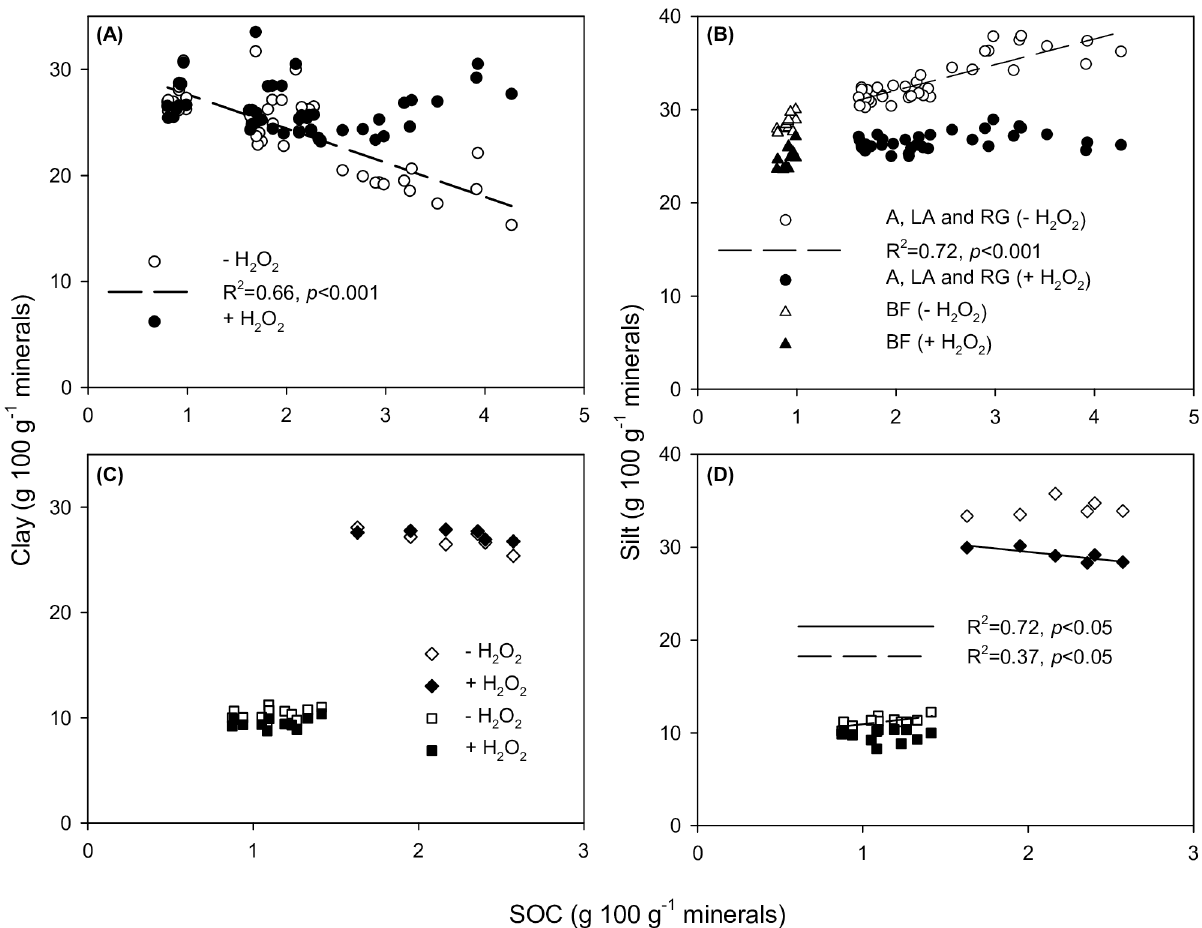
Fig 1. Clay ( < 2 μ m) and silt (2–20 μ m) content as a function of SOC content for soil samples pretreatedwith hydrogen peroxide and without pretreatment. (A) Clay content plotted against SOC content for soil samples pretreatedwith hydrogenperoxide(black symbols) and without pretreatment (white symbols) at Highfield.The linear regression line, R 2 and p -valuefor non-pretreated soil samples are indicated( n = 48). (B) Silt content plotted againstSOC content for soil samplespretreatedwith hydrogen peroxideand without pretreatment at Highfield.The linear regressionline, R 2 and p -valuefor non-pretreated arable(A), ley-arable(LA) and reseededgrass (RG) soil samples are indicated(white circles, n = 36). The bare-fallow(BF) soil samples are shown with trianglesymbols ( n = 24). (C) Clay content plotted againstSOC content for soil samples pretreatedwith hydrogenperoxide and without pretreatmentat Bad Lauchsta¨dt (diamondsymbols) and Askov (square symbols). (D) Silt content plotted against SOC content for soil samples pretreatedwith hydrogen peroxideand without pretreatment at Bad Lauchsta¨dt and Askov. The linear regressionline, R 2 and p -valuefor pretreatedand non- pretreatedsoil samplesfor Bad Lauchsta¨dt ( n = 6) and Askov ( n = 12), respectively,are indicated.